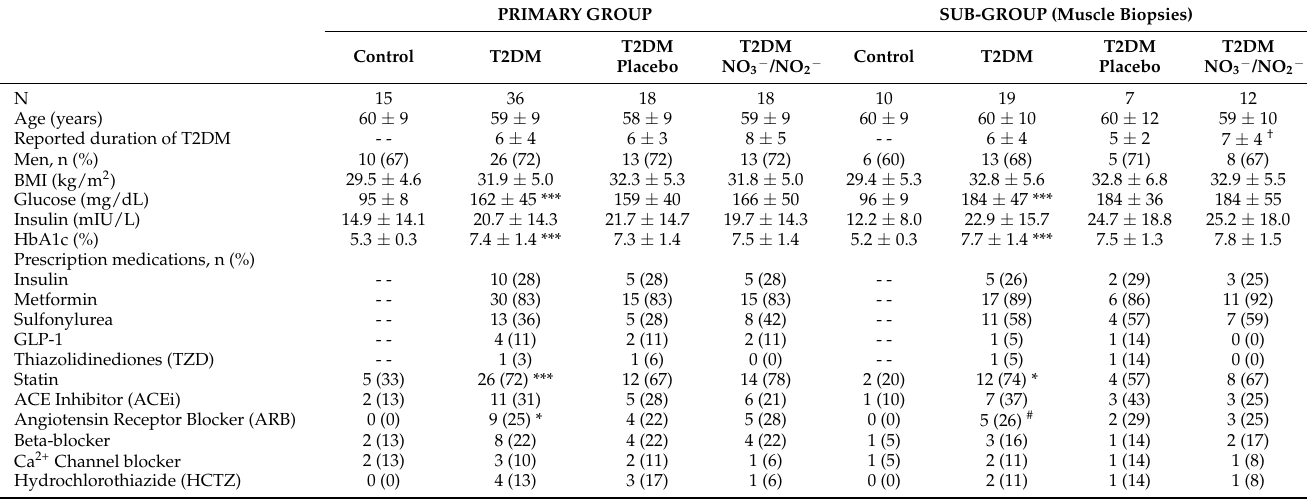
Table 1. Baseline clinical